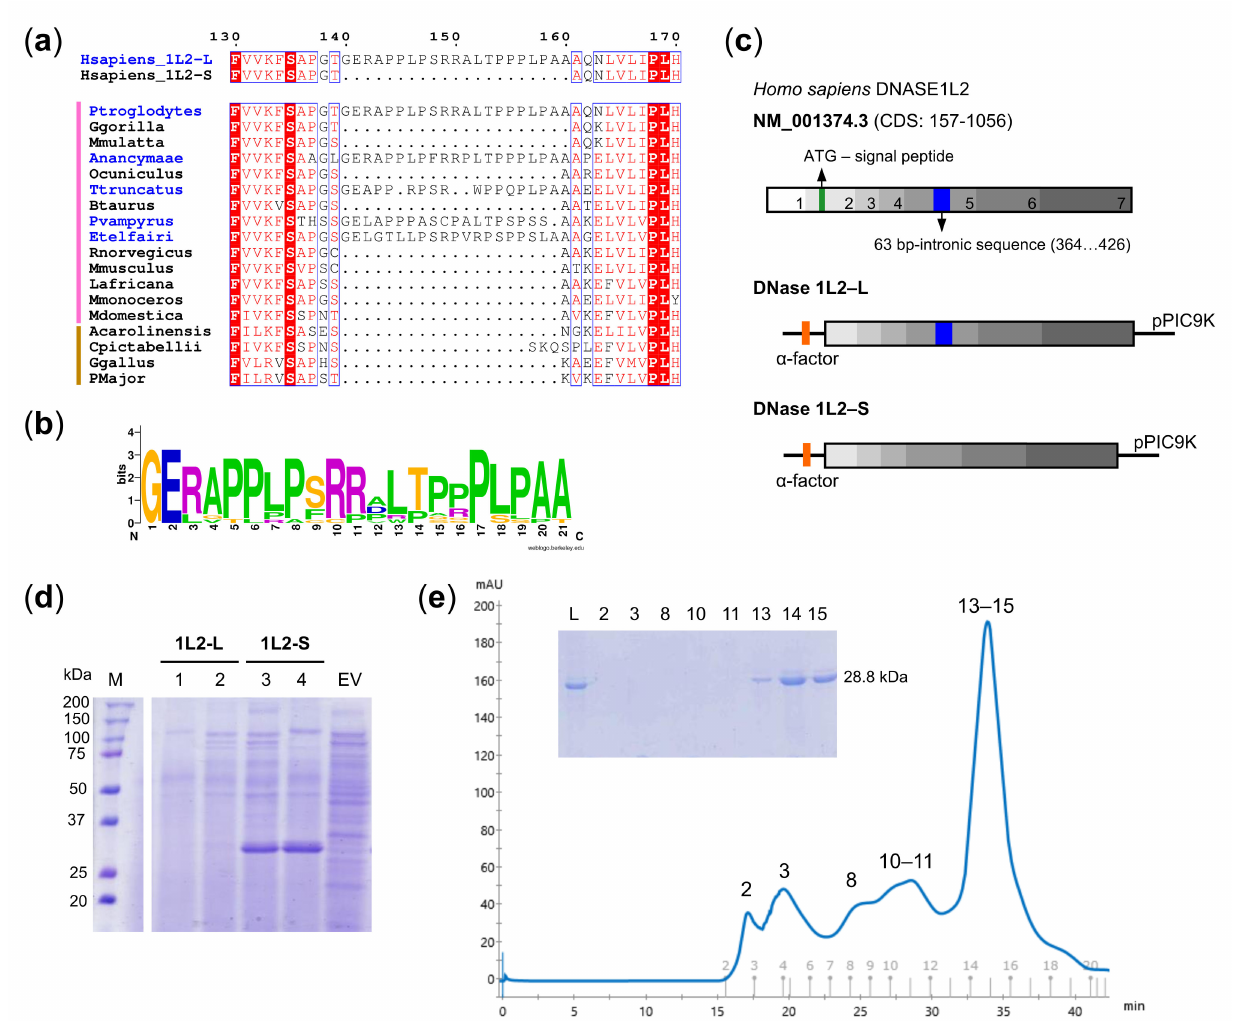
Figure 1. Expression and purification of DNase1L2. ( a ) Portion of multiple alignment showing the proline-rich region present only in some mammalian DNase1L2 sequences (names in blue). Vertical lines on the left indicate sequence from mammals (pink) and sauropsids (brown). ( b ) Frequency plot of the aligned proline-rich regions from thirteen mammalian DNase1L2 sequences showing remarkable conservation. ( c ) Scheme of the DNase1L2 mRNA sequence (NM_001374.3) and the constructs designed for the expression of DNase1L2-L and DNase1L2-S in P. pastoris GS115. CDS lacking the predicted signal peptide were cloned into pPIC9K vector bearing a sequence ( α -factor) for the secretion of expressed proteins. ( d ) SDS-PAGE analysis of extracellular expression of P. pastoris GS115 cells transformed with pPIC9K-DNase1L2-L (two clones, 1 and 2, are shown) or with pPIC9K-DNase1L2-S (two clones, 3 and 4, are shown) or with an empty vector (EV). The band corresponding to DNase1L2-S is found at the expected molecular weight of 28.8 kDa. M: Marker. ( e ) Size-exclusion chromatogram and SDS-PAGE (inset) showing the final step of DNase1L2 purification. Numerals above peaks correspond to the gel lanes in the inset. L: